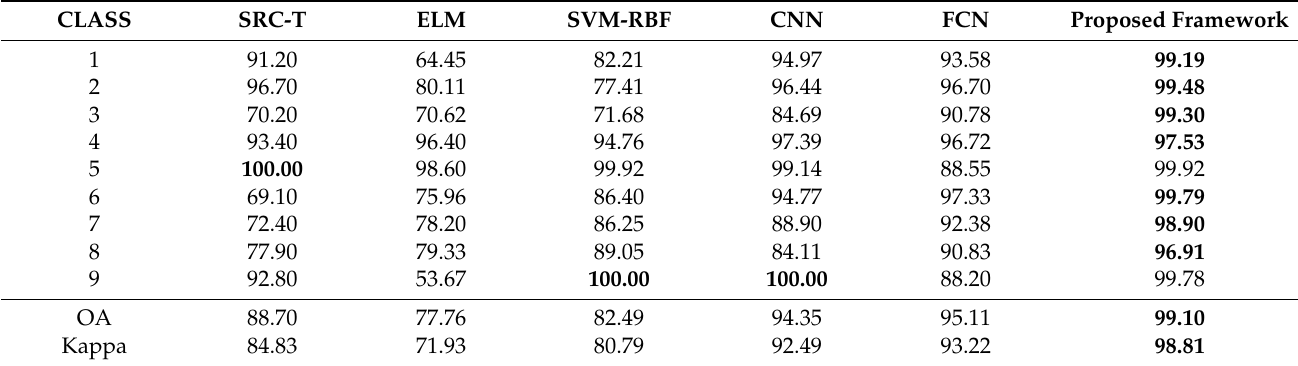
Table 4. Classification accuracy (%) for the Pavia university dataset via different algorithms.